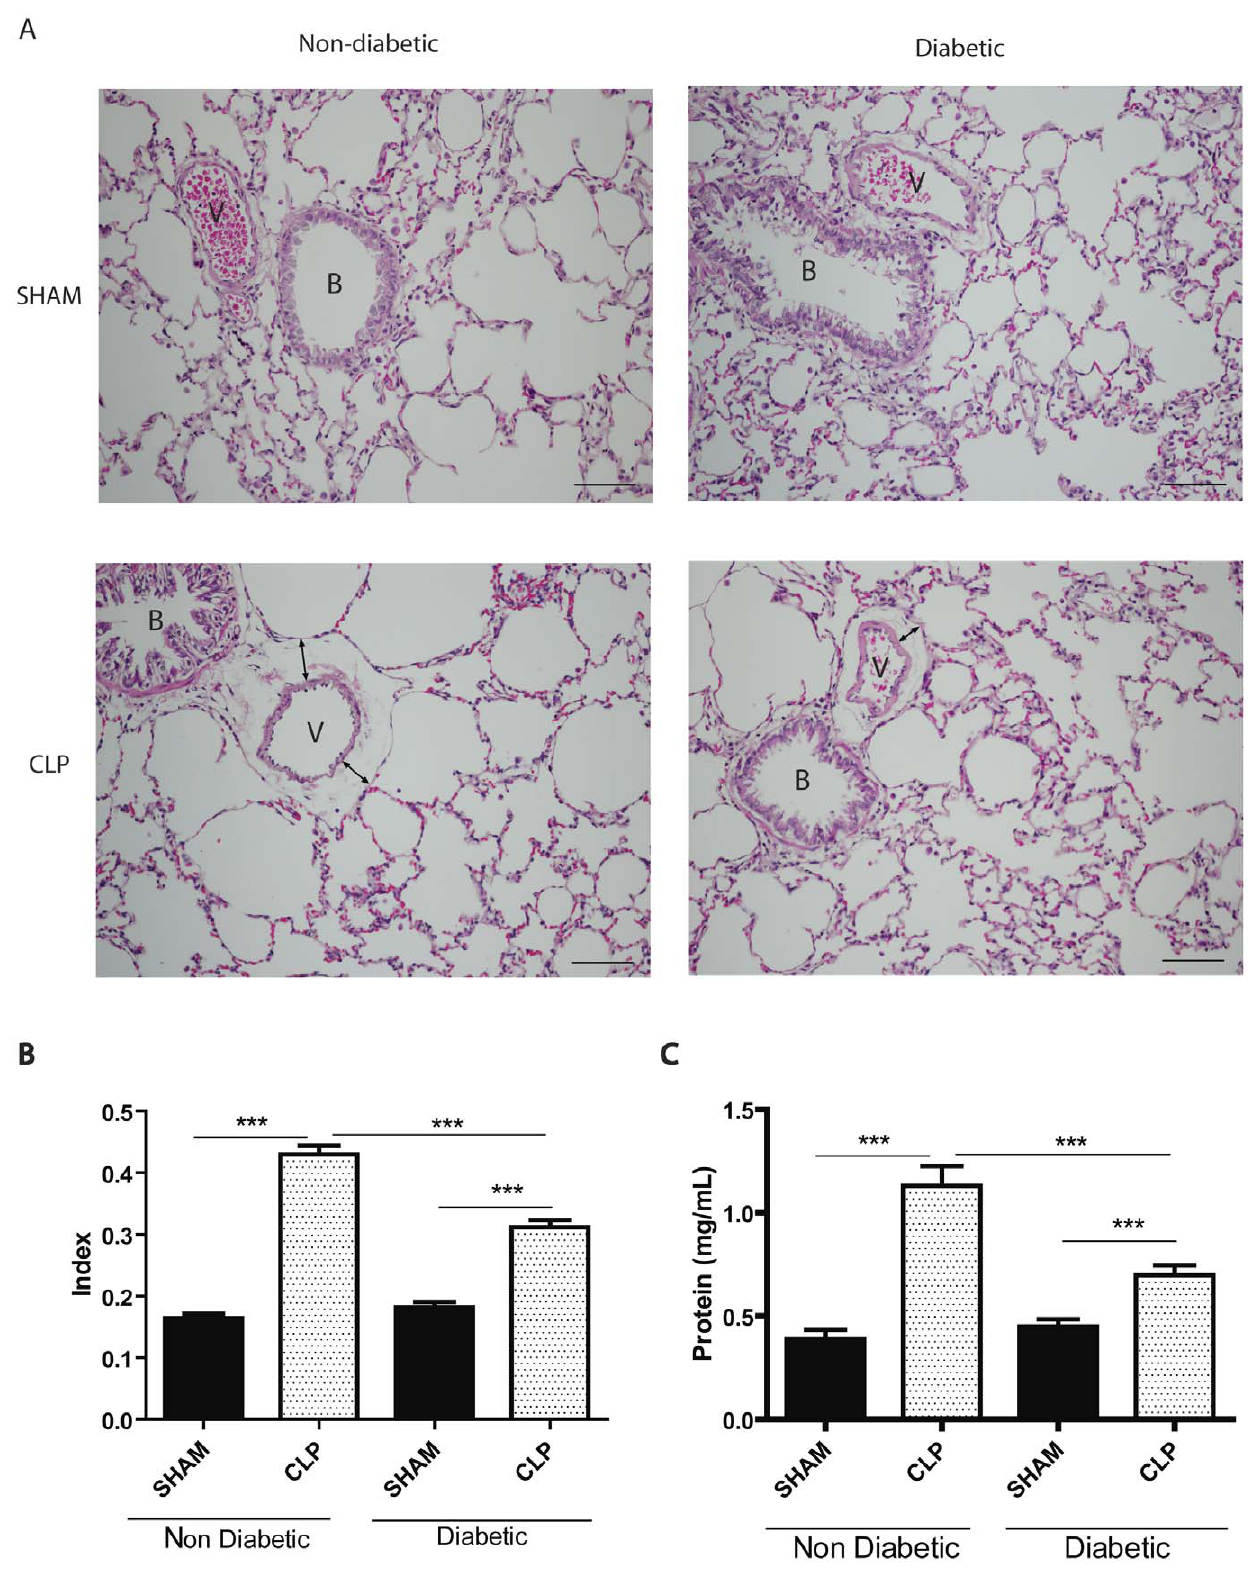
Figure 2. Lung oedema at 6 h after CLP. Diabetic and non-diabetic rats were submitted to CLP and after 6 h the lungs were removed and processed. ( A ) Photomicrographs of peribronchovascular axis in lung stained with haematoxylin-eosin; ‘ B ’ stands for bronchiole and ‘ V ’ for venule. Note the presence of oedema around the venule (leakage area marked in black bars). Photographs were taken at an original magnification of 200x. ( B ) Quantification of perivascular oedema by light microscopy with an integrating eyepiece with a coherent system consisting of a grid with 100